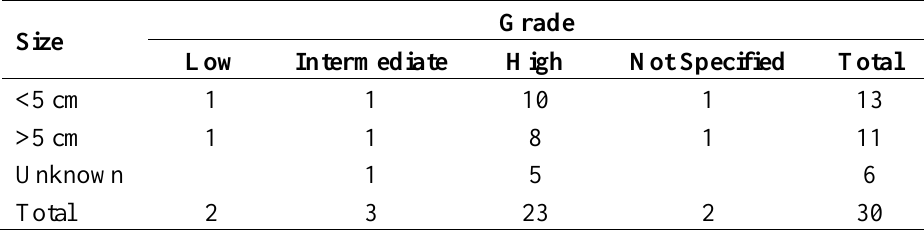
Table 2. Patient distribution according to tumor size and